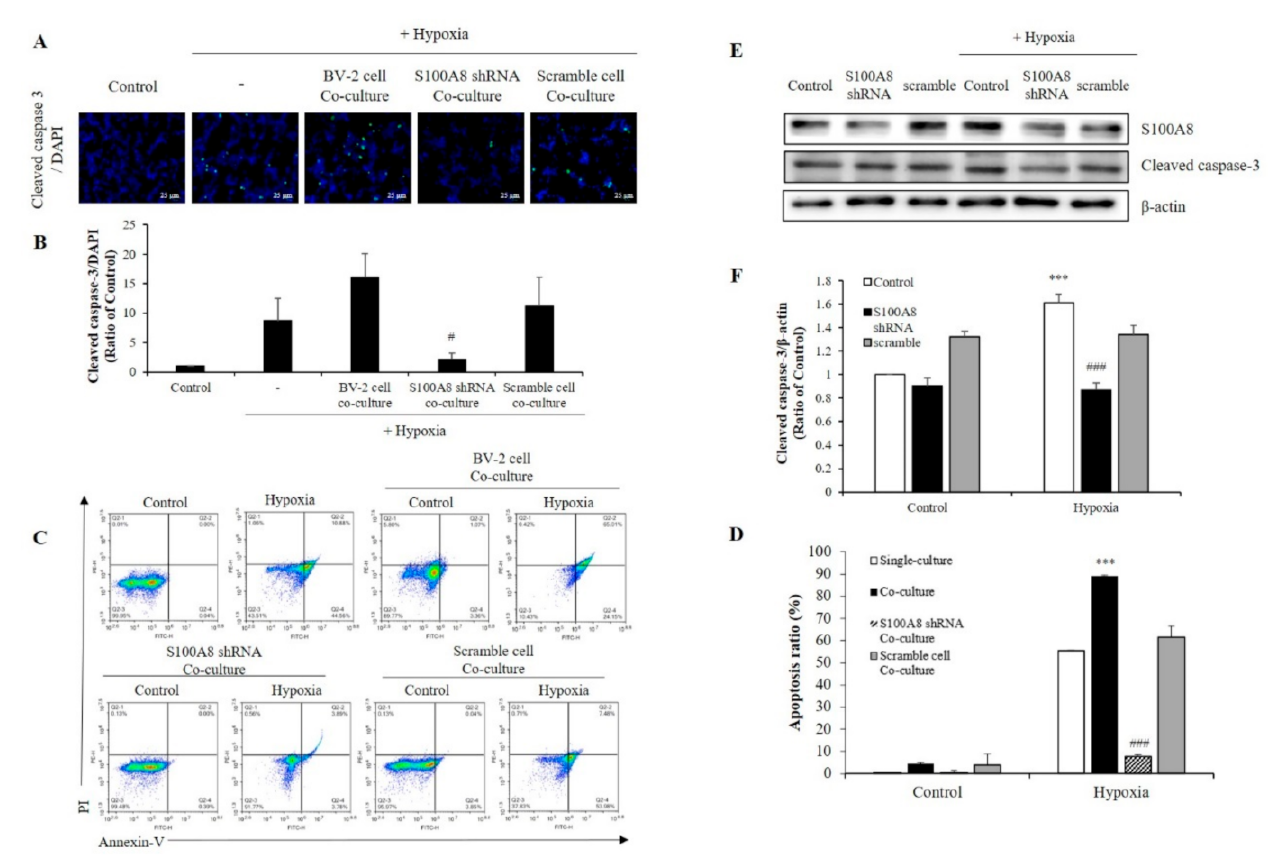
Figure 5. The expression of S100A8 in microglial cell induces apoptosis of neuronal cells in hypoxic condition. ( A , B ) SH-SY5Y cells incubated without or with S100A8 KD BV-2 cells for 48 h in hypoxic condition. Cleaved caspase-3 immunofluorescence images and were detected and quantitative analysis of the number of cleaved-caspase3-positive cells are shown in lower panel. ( C , D ) Representative Annexin-V/PI images were detected by flow cytometry. Quantitative analysis of the apoptotic rate of SH-SY5Y cells are shown in lower panel. ( E , F ) Primary neuron-glial mixed cells were transfected with S100A8 shRNA vector for 24 h followed by 48 h in hypoxic condition. Cells were harvested, and the expression protein levels of S100A8 and cleaved caspase-3 were analyzed by Western blotting. Data from three independent experiments are presented as the means ± S.D. Values of *** p < 0.001 versus control; # p < 0.05, ### p < 0.001 versus hypoxia-exposed sample were considered as statistically